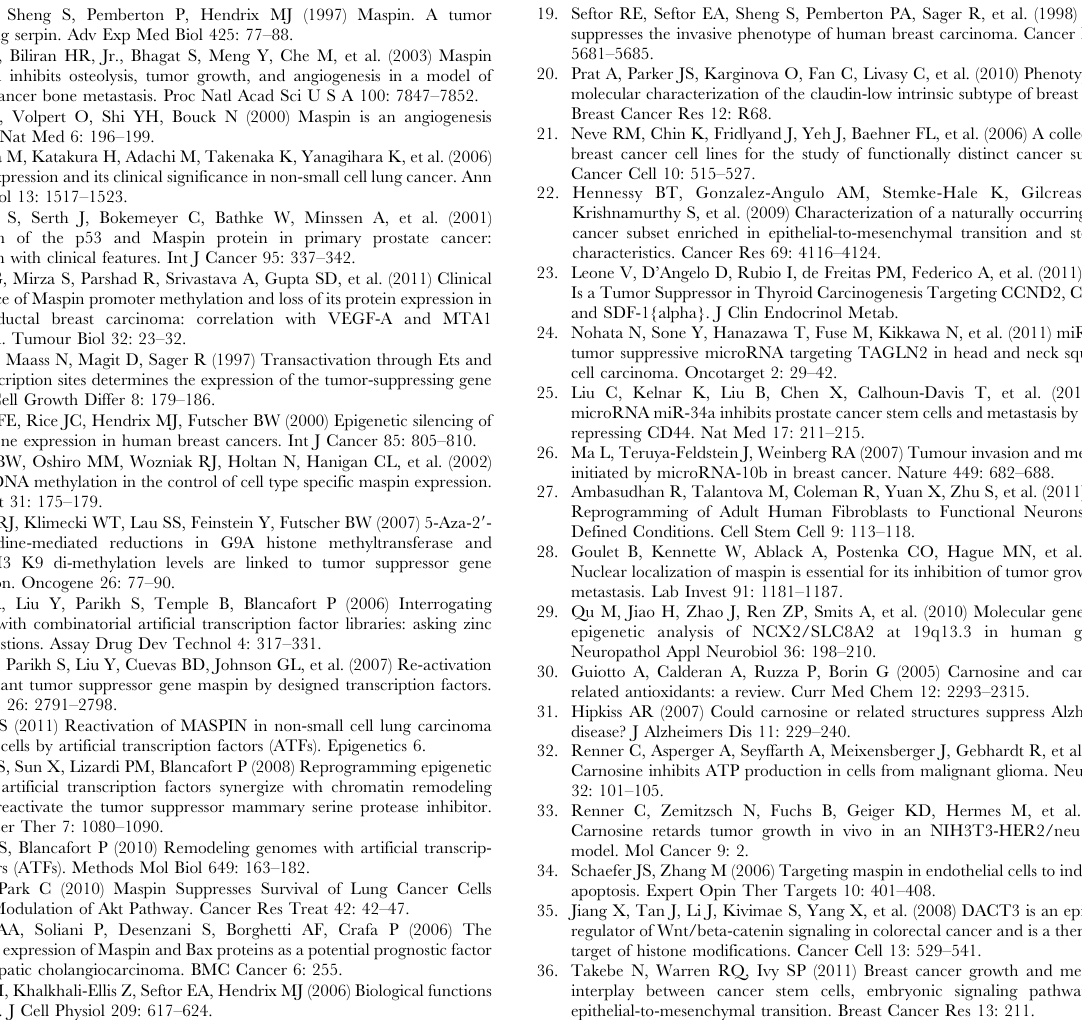
Table S2 Pathway analysis of the 550-gene signature using the David database (http://david.abcc.ncifcrf. gov/). Table S3 Antibodies used in this study. Table S4 Primers and probes used in this study. Table S5 Genes differentially regulated with the Mas- pin